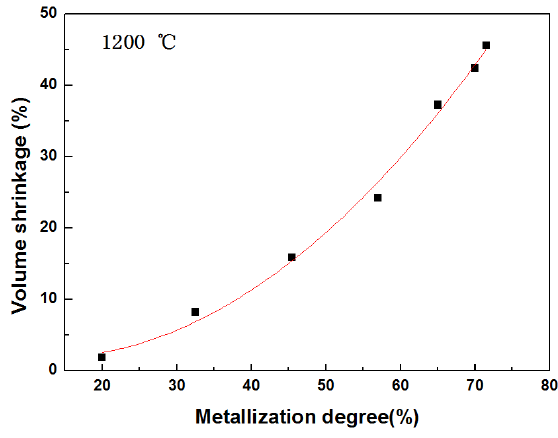
Figure 12. Correlation of volume shrinkage vs metallization degree of the pellets reduced at 1200 °C.